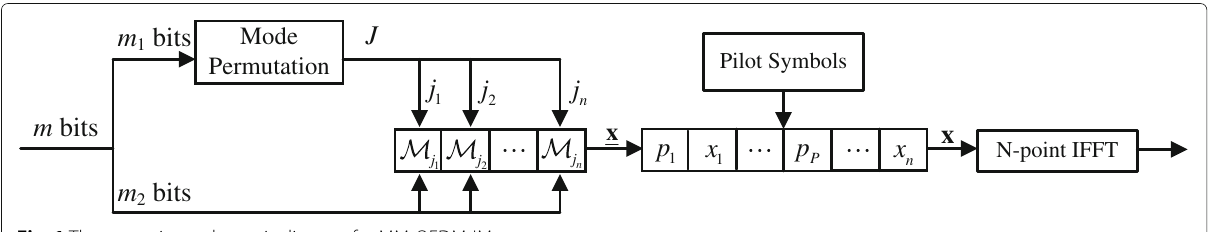
Fig. 1 The transmitter schematic diagram for MM-OFDM-IM systems